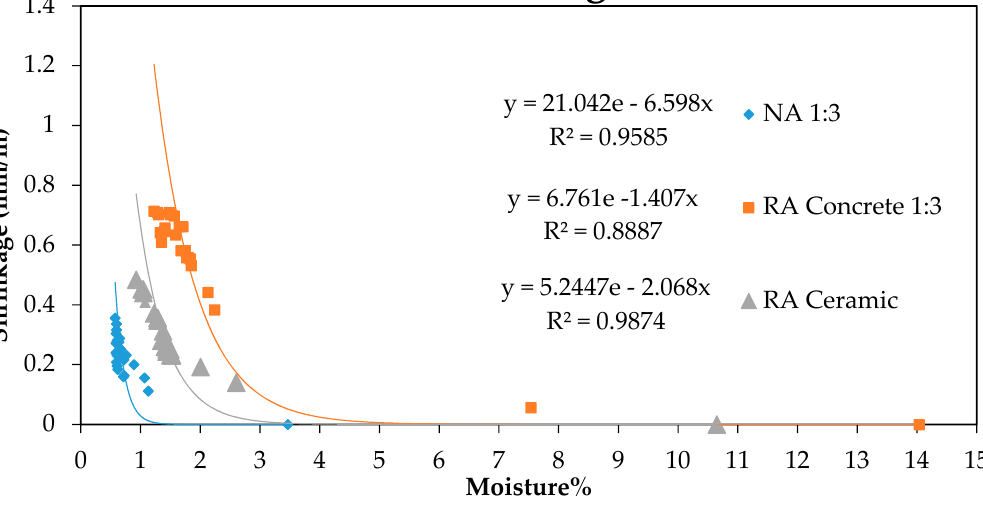
Sensors 2017 , 17 , x FOR PEER REVIEW Figure 5. Relation Moisture–Shrinkage for mortars with 1:3 dosage. Figure 5. Relation Moisture–Shrinkage for mortars with 1:3 dosage.